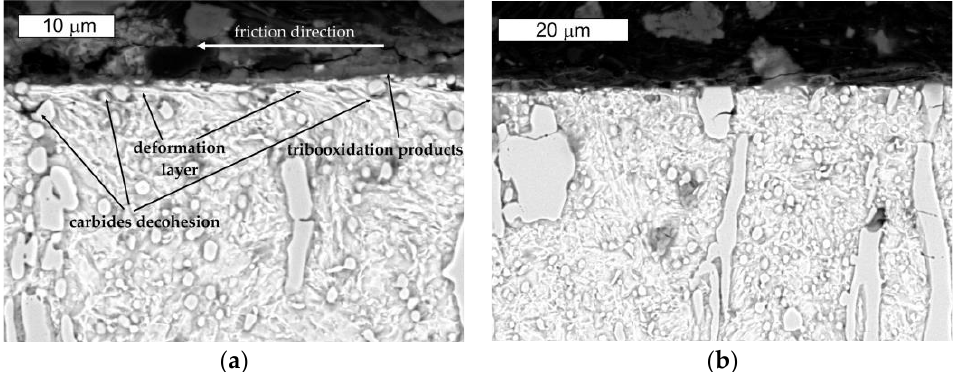
Figure 19. View of ( a ) the microstructure of steel NC11 in the surface area and ( b ) a magnified fragment from the area in Figure 19a. Longitudinal direction to the friction direction. Light microscopy, etched.